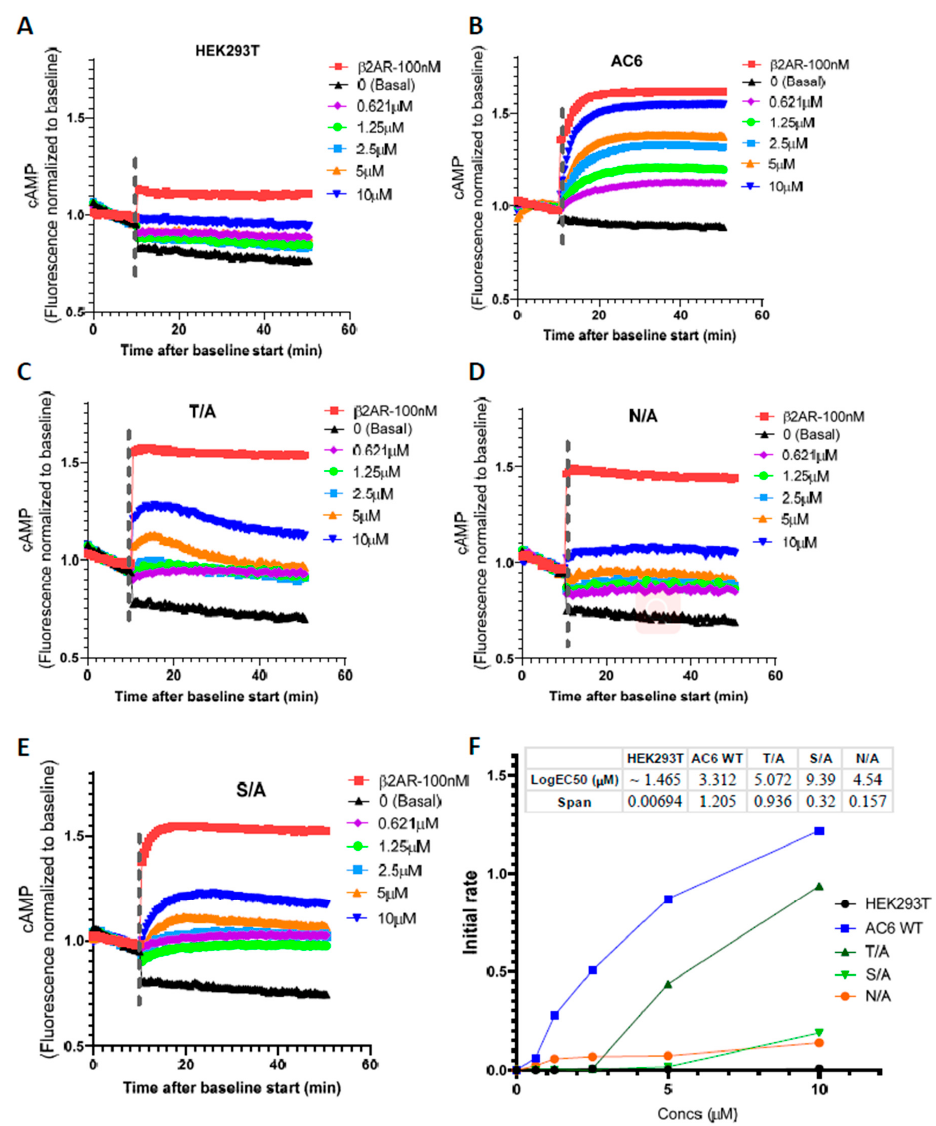
Figure 8. cAMP dynamics in live naïve HEK293T, or stable cell lines expressing AC6WT or FSK site mutants, using the cAMP difference detector in situ (cADDis) assay. Dose-response cAMP kinetic analysis for forskolin was performed in HEK293K cells ( A ), AC6 WT ( B ), mutants T/A (C) , N/A (D) , S/A ( E ). Kinetic rate constants ( F ) were derived from the shared constrained plateau of one-phase decay analysis among HEK293T, AC6 WT, and FSK binding mutants. Cells were incubated with recombinant baculovirus modified with a mammalian promoter expressing the cADDis cAMP sen- sor for 24 h. After baseline values were established, fluorescence decay was monitored for a 40 min time course after the addition of forskolin in a dose-dependent manner (0.621–10 μ M). cAMP gen- eration by β 2AR-expressing HEK293T cells challenged with agonist isoproterenol (100 nM) used as